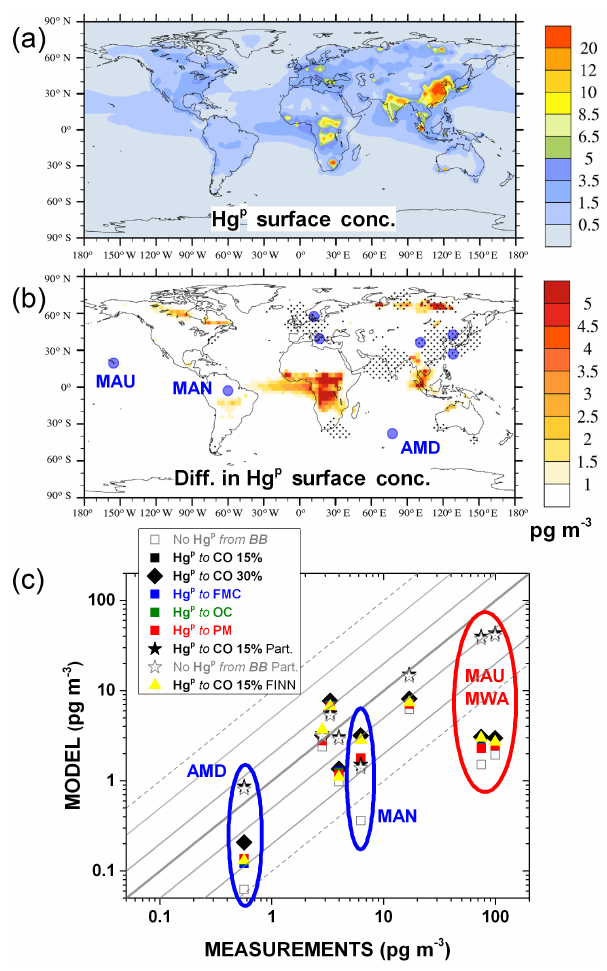
Figure 9. (a) Annual averaged surface Hg P concentrations as sim- ulated by BASE run including all emission sources. (b) Differ- ences in annual averaged surface Hg P concentrations as simulated by BASE and by NO Hg P runs, both including emissions from all sources. Black dots indicate that differences are not significant based on a Student t test at a 95% confidence interval. Blue big- ger points indicate the locations of measurements sites reported in Table 2. Short names are depicted for sites where the differences between BASE and NO Hg P runs are significant. (c) Scatter plot of annual averaged Hg P concentrations measured at sites of Table 2 compared with those obtained by different sensitivity runs. The blue circles in the figure indicate values relative to the sites further inves- tigated at an higher temporal resolution (see Fig. 10), whereas the red circles indicate values relative to high-altitude sites affected by processes other than